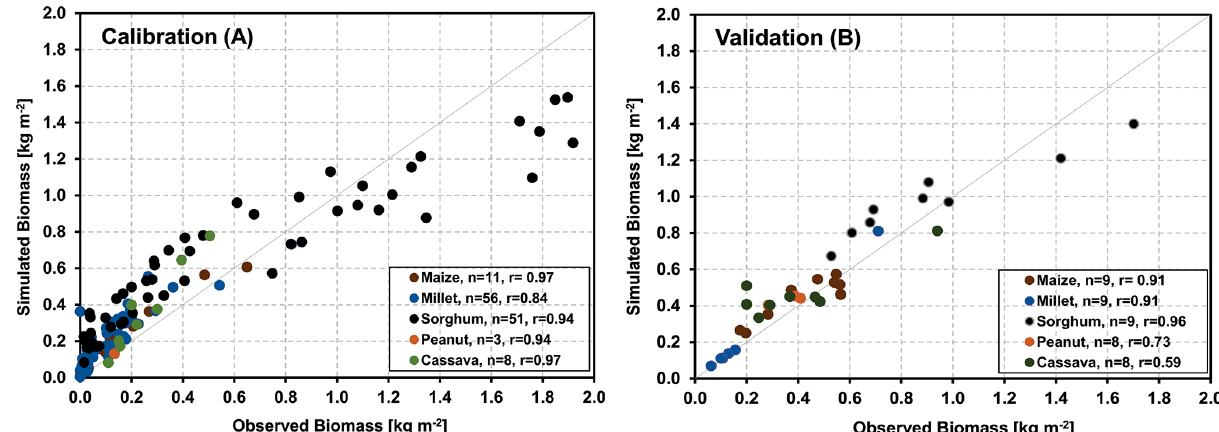
Figure 4. (a) Observed and simulated annual biomass/yield production for crop-dominated sites involved in the calibration process over all 18 investigated years; panel (b) is the same as panel (a) but for 17 years at six additional validation